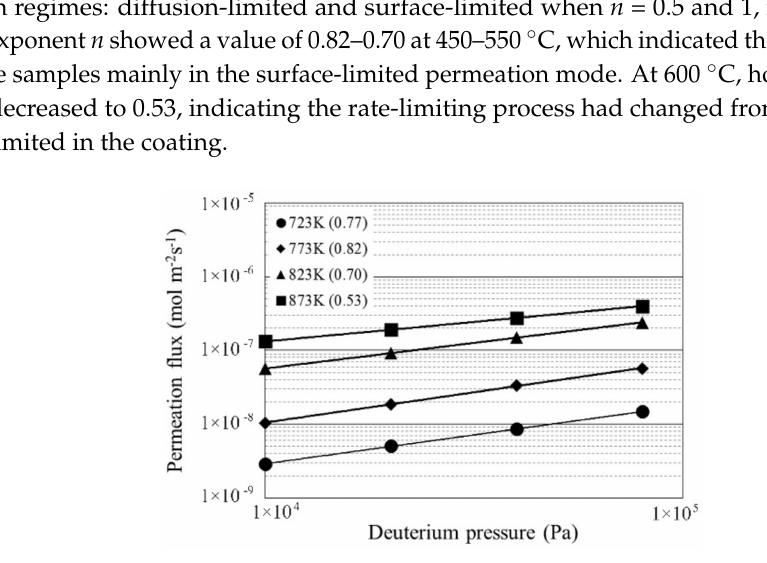
Figure 12. Deuterium permeation flux through the composite coated sample as a function of the driving pressure at different